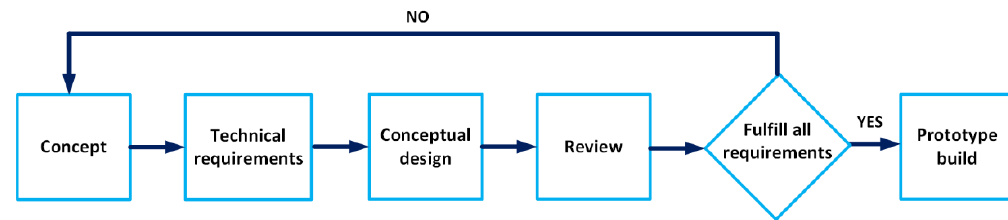
Figure 3. Schematic of the design